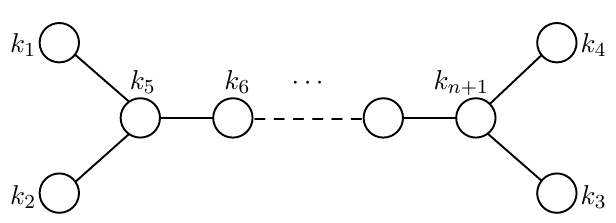
Figure 2 . b D n quiver diagram. Each node ‘ a ’ corresponds to a U( n a N ) gauge group with CS level k a , where n a is the node’s comark and P